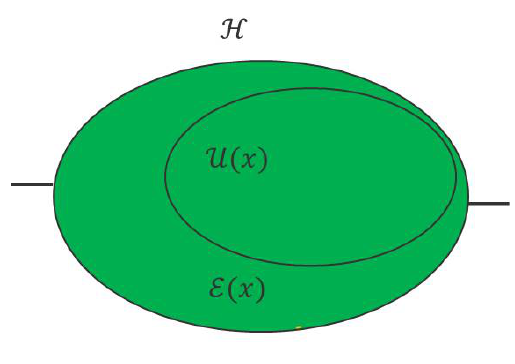
Figure 8: Examples of functions for unexamined parts of H . Such curves may be relevant and appli- cable for complex requirements (upper curve could